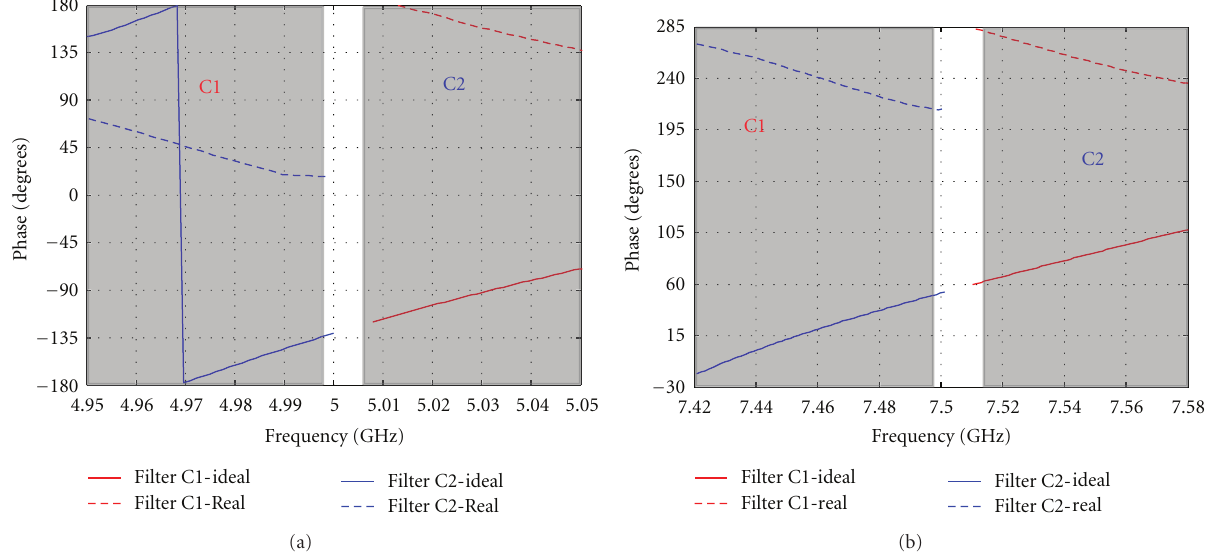
Figure 18: Out-of-band S22 phases profile of real filters, compared to the ones of ideal filters at f L (a) and f H (b).